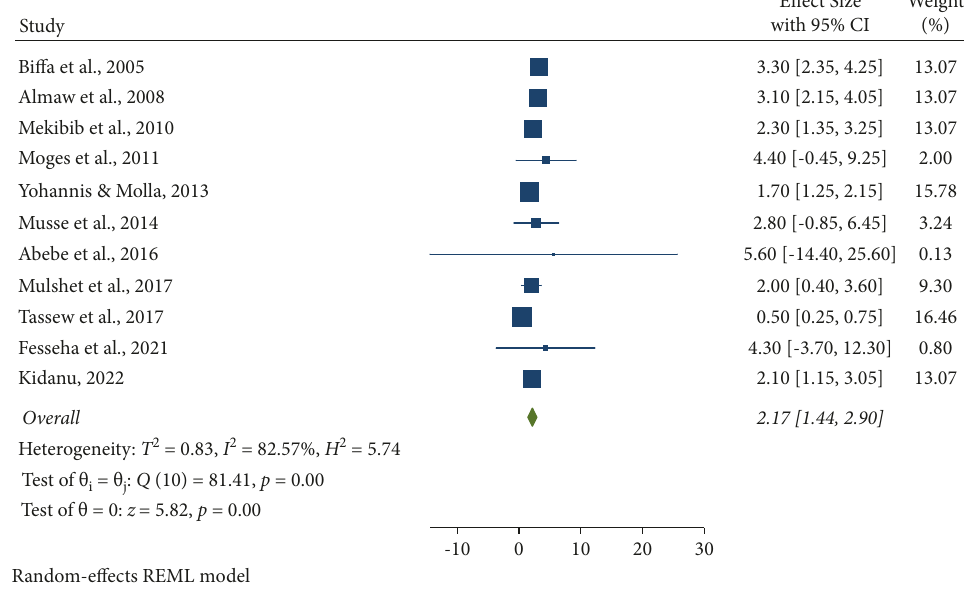
Figure 9: Breed as an associated risk factor for mastitis among dairy cows.